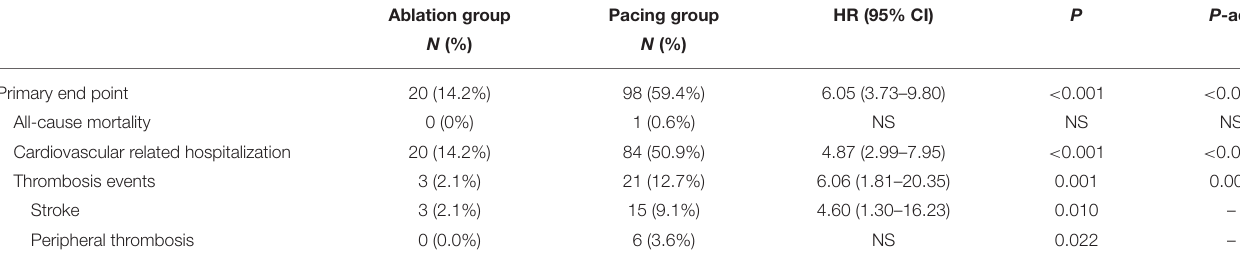
TABLE 4 | Comparison of the primary end point between ablation group and pacing group.